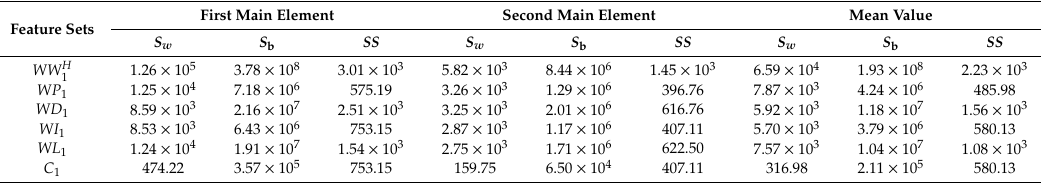
Table 4. Divergence calculation results of six di ff erent fault-feature sets in experiment data